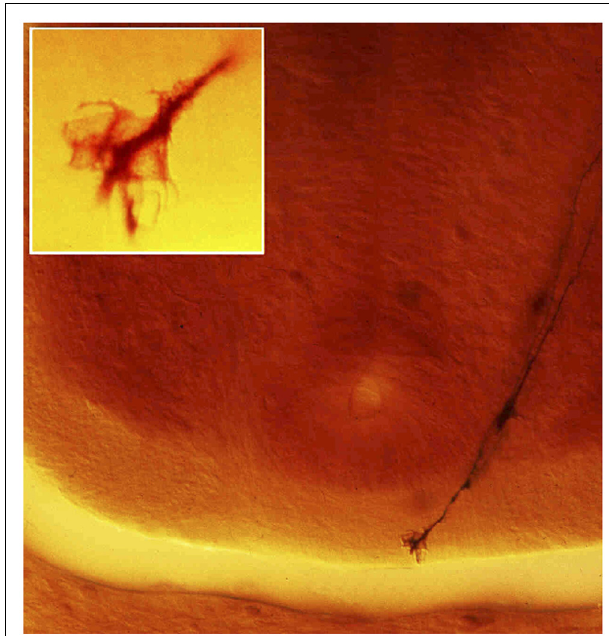
FIGURE 2 |Transverse section of the spinal cord of a day 4 Chick embryo taken by the authors from one of Cajal’s original Golgi slides (preserved at the “Instituto Cajal” in Madrid) that led him to describe the growth cone in 1890; a crucial finding in the establishment of the neuronal theory and of the trophic theory. Cajal thought that developing neurons possessed chemotactic properties that would guide axons to their targets and he suggested that the growth cone would be guided by chemicals to find their secretory target.The figure shows two commissural axons running towards the floorplate to cross the midline. Cajal described this as follows: “This fibre ends ... in an enlargement which may be rounded and subtle, but that may also adopt a conical appearance.This latter we shall name the growth cone, that at times displays fine and short extensions ... which appear to insinuate themselves between the surrounding elements, relentlessly forging a path through the interstitial matrix. ”The insert shows a higher magnification of the growth cone of one of these fibers (from Nieto,